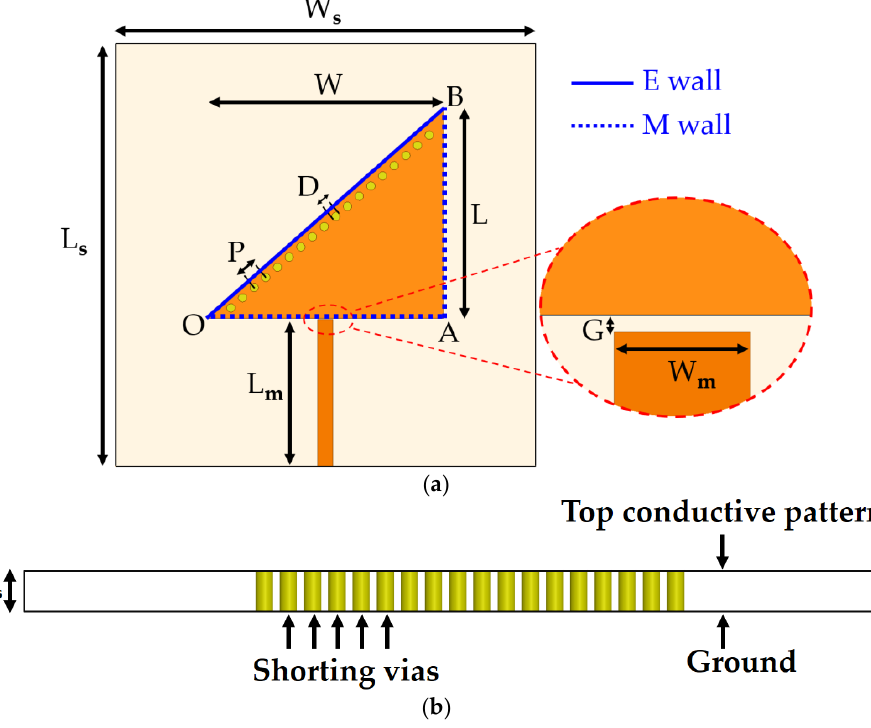
Figure 3. Geometry of the TM 02 -mode QMSIW resonator proposed as a dual-detection chemical sensor: ( a ) top view. L s and W s represent substrate’s (length and width), L m and W m represent microstrip line’s (length and width), OA, AB and OB represent dimensions of triangular patch; ( b ) cross-sectional view.